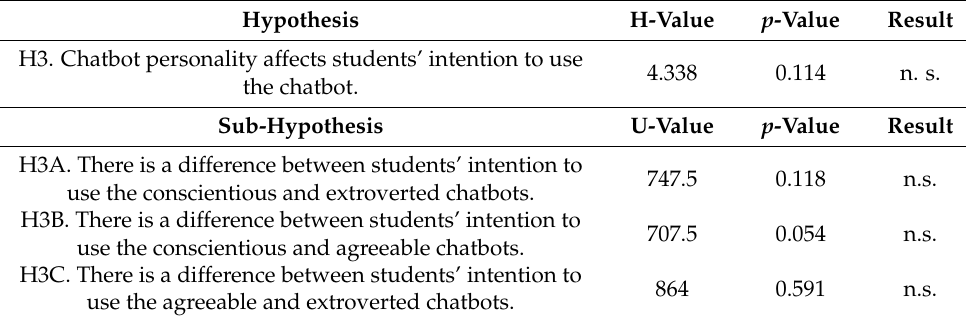
Table 5. Hypothesis 3 Testing Results.